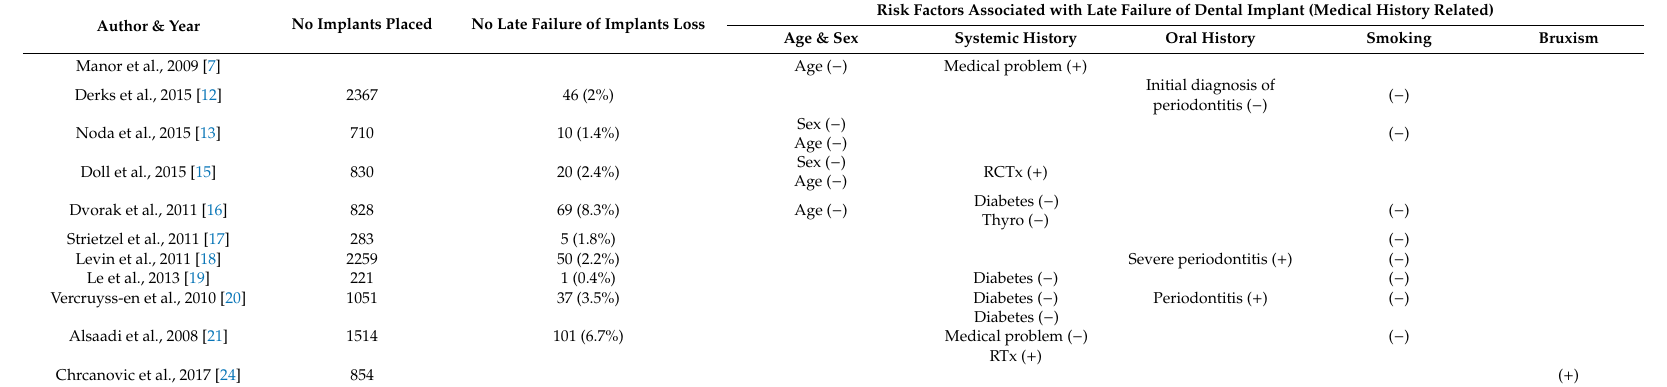
Table 1. Studies that have evaluated the risk factors associated with late dental implant failure (part 1).